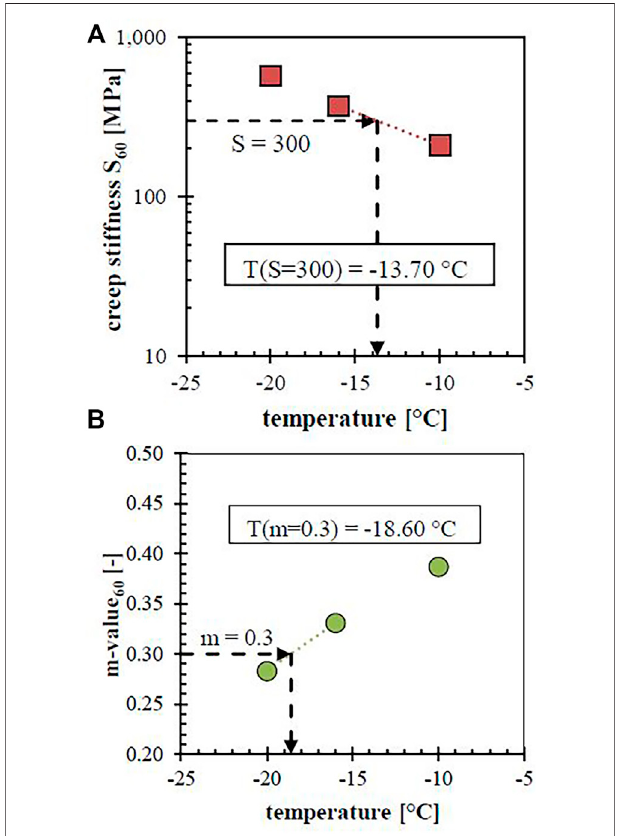
FIGURE 5 | Example for determining characteristic temperatures of asphalt binder 10/40-65: (A) T ( S = 300), and (B) T ( m = 0.3).